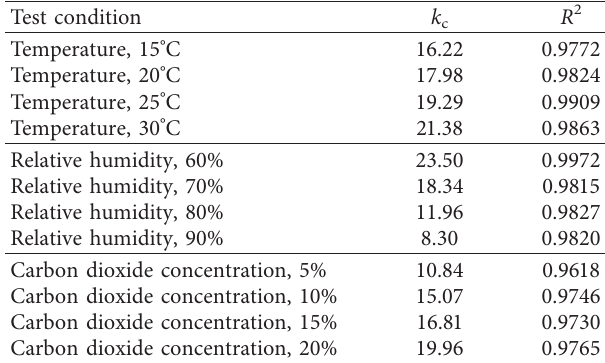
Table 4: Carbonation coefficients obtained during accelerated carbonation